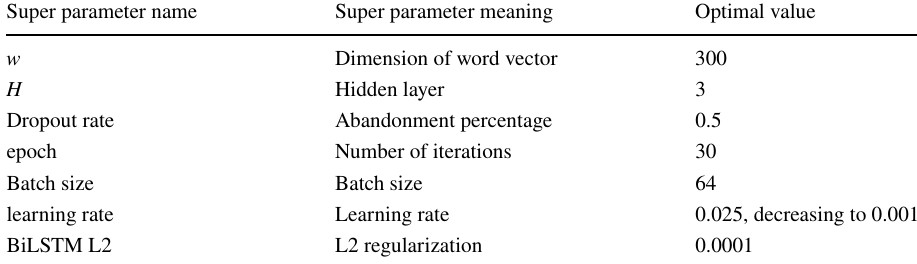
Table 7 BiLSTM-based network model hyperparameters